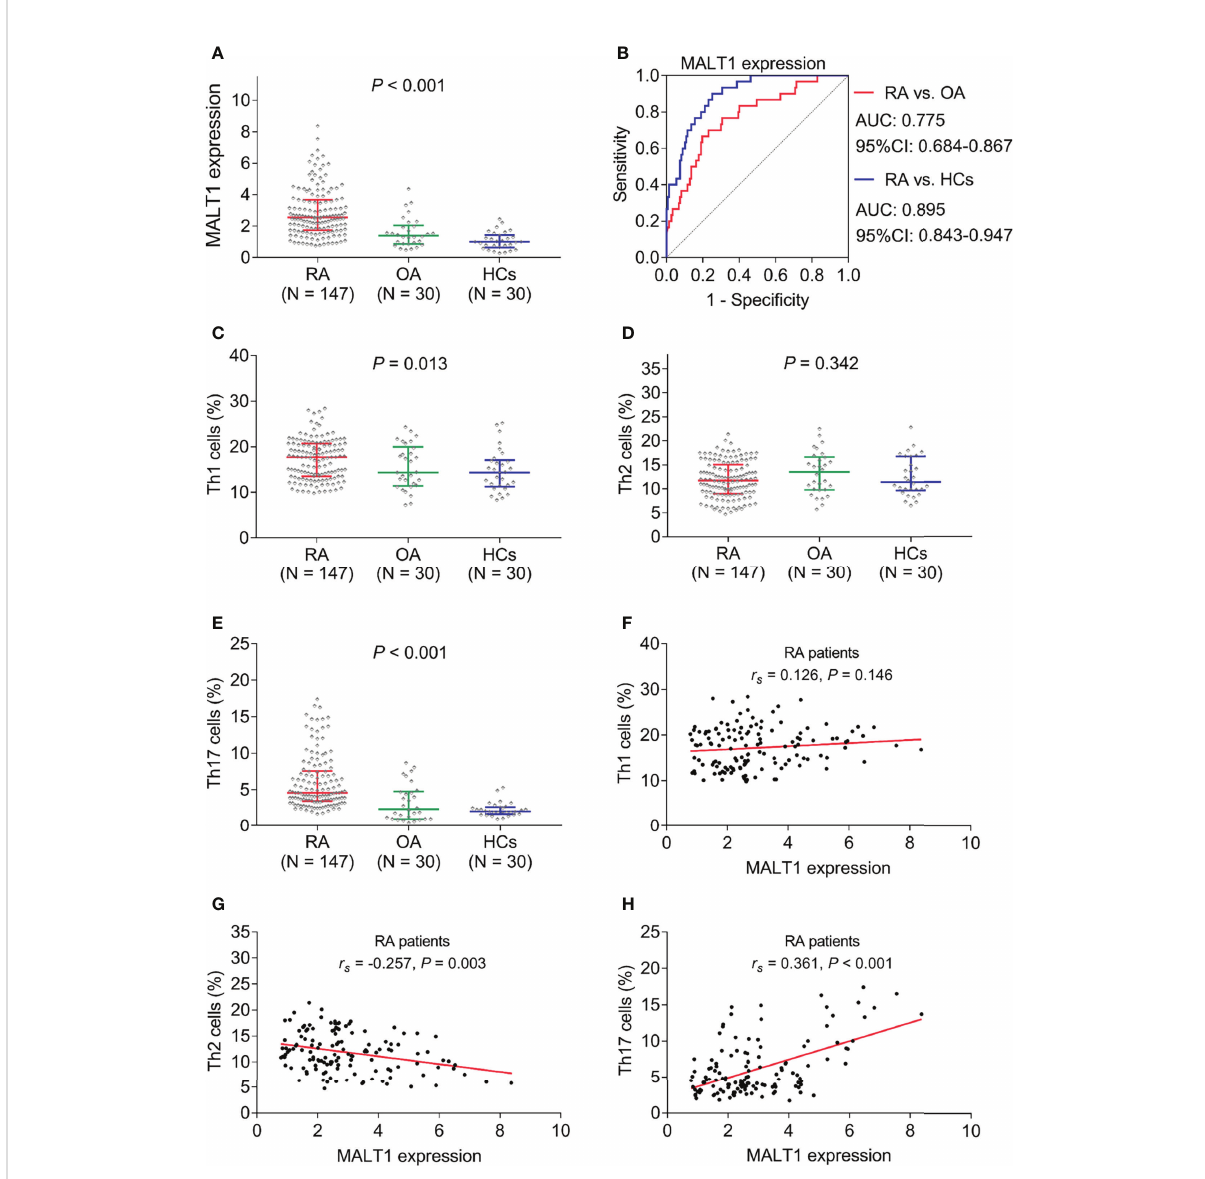
FIGURE 2 MALT1, Th1 cells, Th2 cells, and Th17 cells among subjects. MALT1 expression among RA patients, OA patients, and HCs (A) . ROC curve analysis of MALT1 ’ s value in differentiating RA patients from OA patients and HCs (B) . Th1 cells (C) , Th2 cells (D) , and Th17 cells (E) among RA patients, OA patients, and HCs. Correlation of MALT1 with Th1 cells (F) , Th2 cells (G) , and Th17 cells (H) in RA